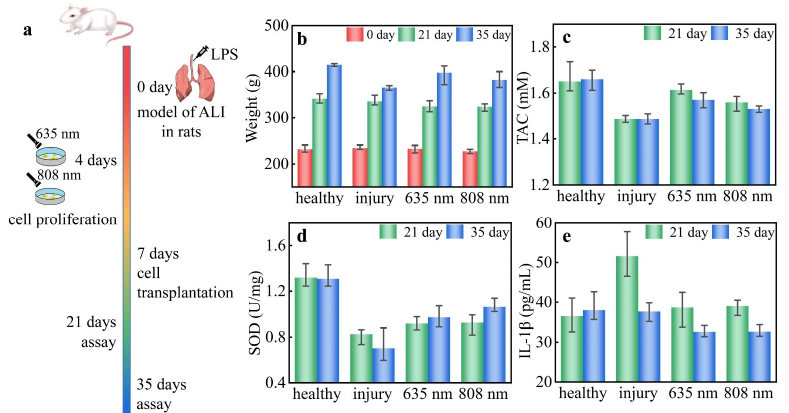
Figure 1. ( a ) Schematic illustration of the ALI model under LLLT. The ( b ) weight, ( c ) TAC, ( d ) SOD, and ( e ) IL-1 β of the rats with ALI under